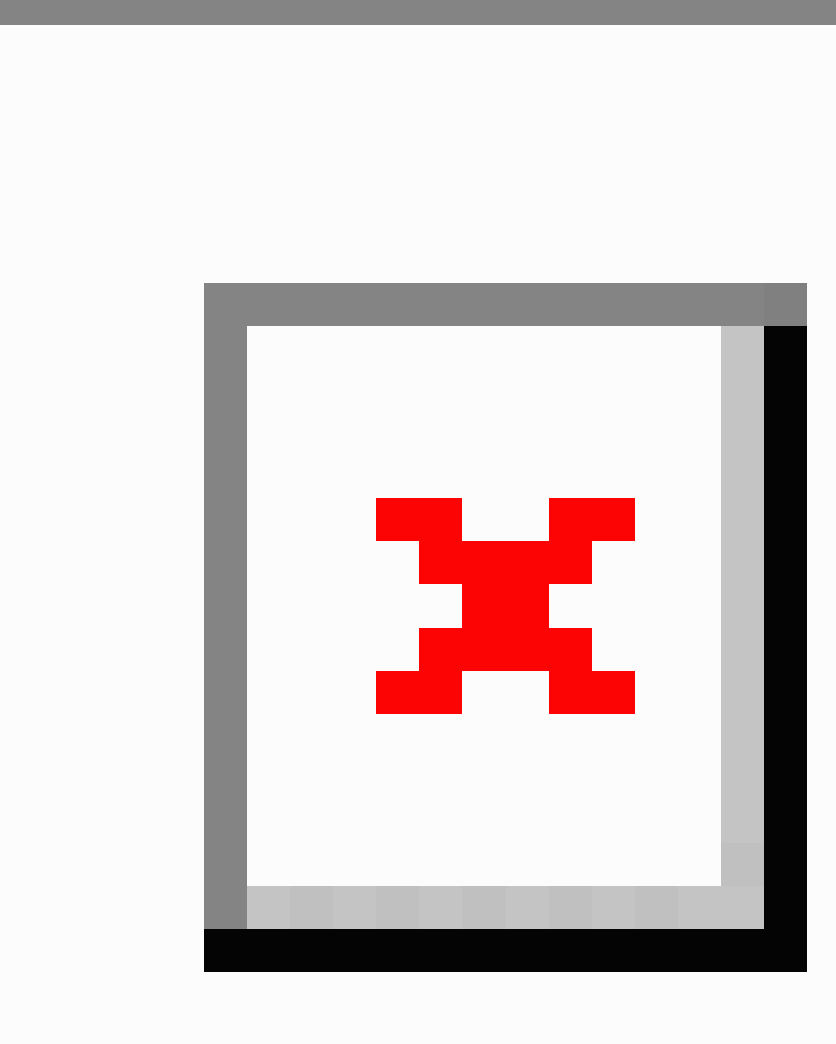
Figure 1. Start desktop of